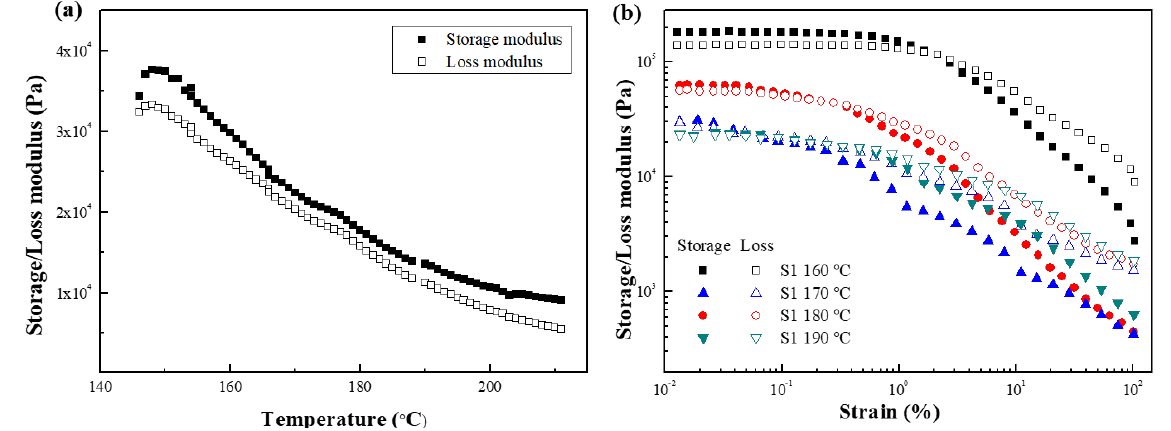
Figure 4. Storage (closed symbols) and loss (open symbols) modulus of ( a ) temperature sweep test and ( b ) strain amplitude sweep test for S1 at various